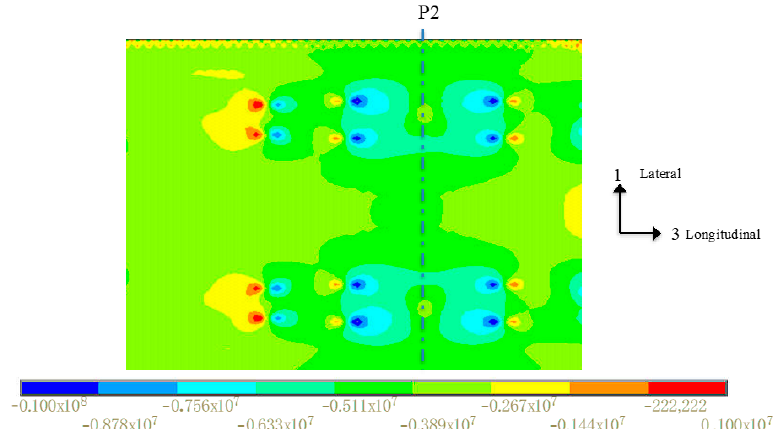
Figure 5. Stress at the top surface of the concrete deck under the constructed condition in the hogging region